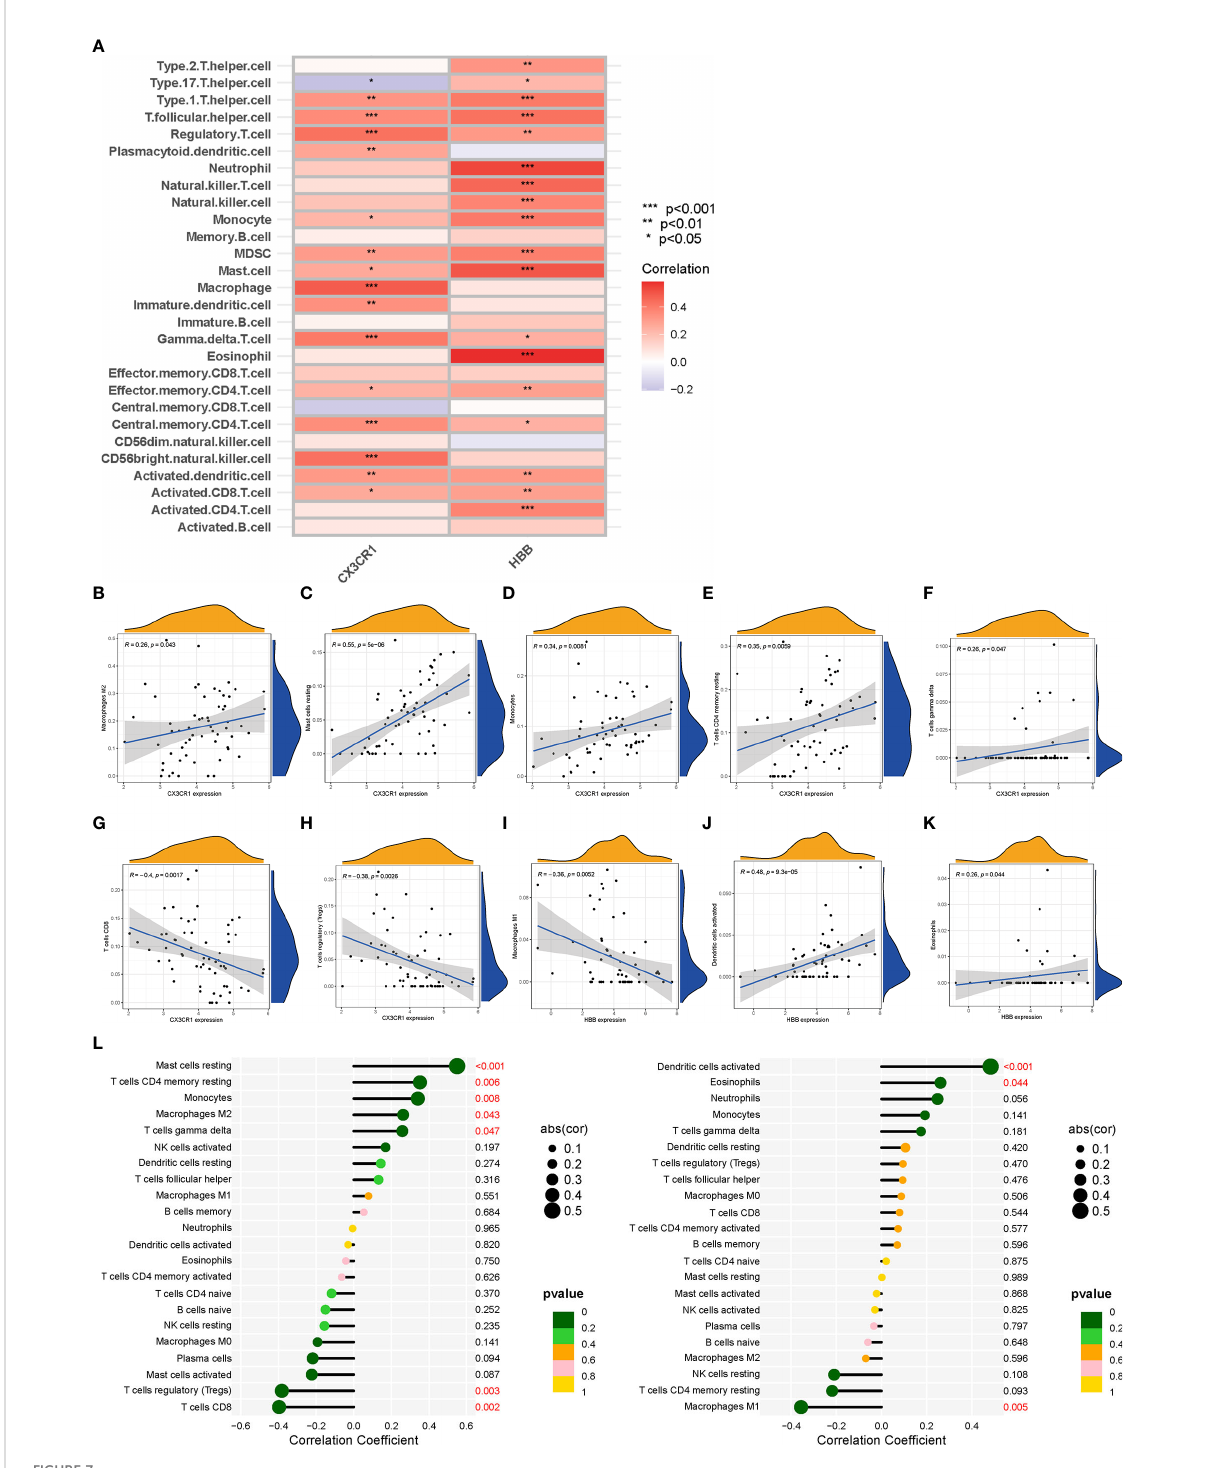
FIGURE 7 Correlation analysis between biomarkers ( CX3CR1 and HBB ) and in fi ltrating immune cell types. (A) The relationship between 28 in fi ltrating immune cell types and two biomarkers; the redder the color, the more signi fi cant the difference. “ *** ” , “ ** ” , “ * ” represent P< (0.001, 0.01, 0.05). (B – H) Correlation between CX3CR1 expression and in fi ltrating immune cell types. (I – K) Correlation between HBB expression and in fi ltrating immune cell types. (L) Correlation between CX3CR1 and HBB and in fi ltrating immune cell types. The larger the dot, the stronger the correlation (cor). Numbers with P-value < 0.05 are marked